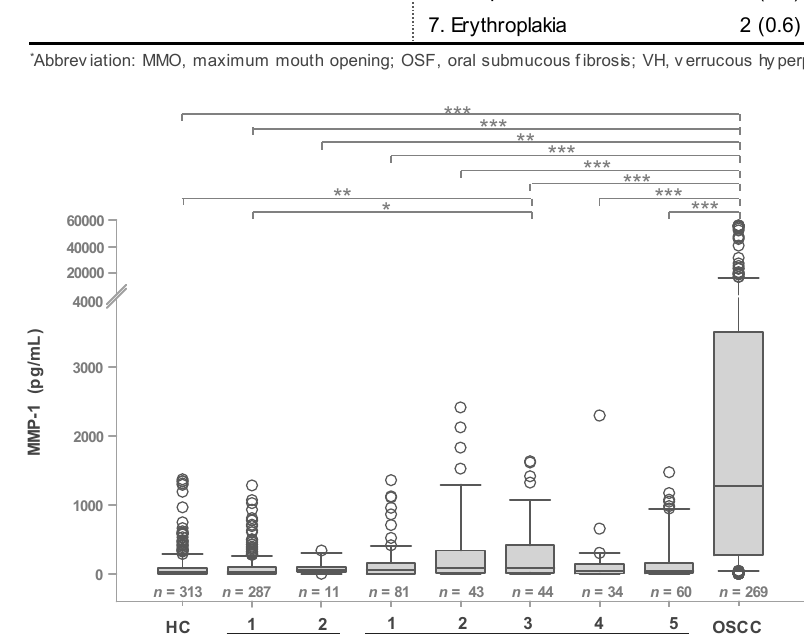
Figure 3. Differential expression levels of salivary MMP-1 in OPMD I and OPMD II. ( A ) Diagnostic types of OPMD I and OPMD II cases in this study. ( B ) Associations between salivary MMP-1 content in HC, different types (case no. > 10) of non-cancerous OPMD I and OPMD II, and OSCC. * p < 0.05, ** p < 0.01. *** p < 0.001.